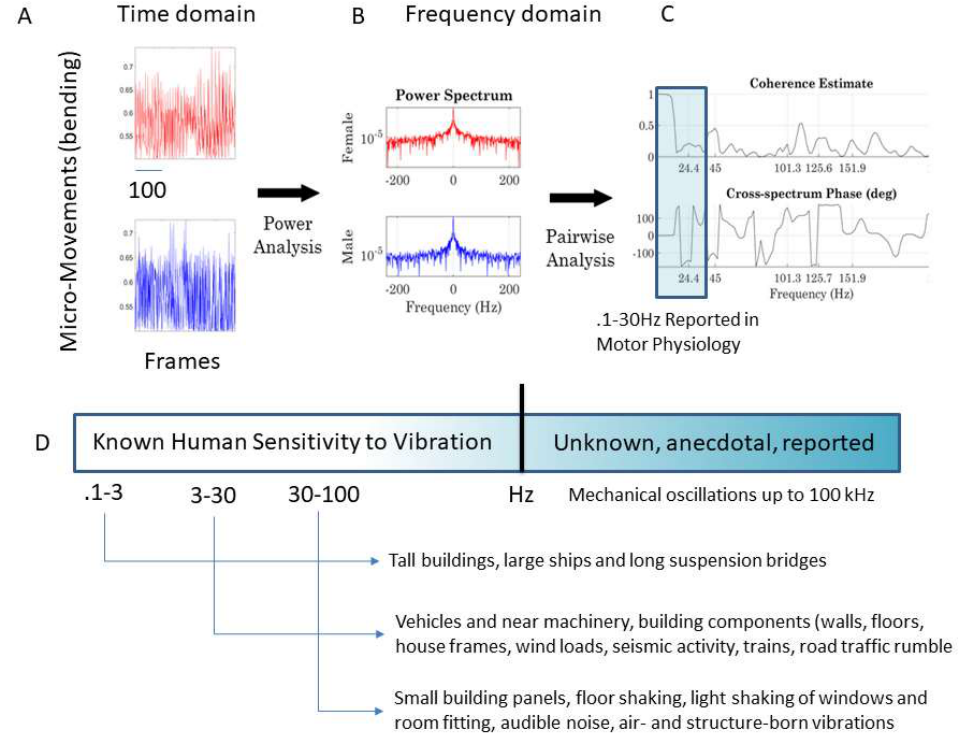
Figure 6. From the time to frequency domain. ( A ) The MM frames from different body nodes are FFT to perform power spectral analyses ( B ) and then pairwise cross-coherence analyses yield the frequency of the peaks (x-axis) and the phase shift (y-axis) in ( C ). ( D ) Frequency ranges studied in human motor control vs. other ranges studied in disciplines that ascertain levels of detectable vibration that may be in some cases harmful to the human nervous systems. Higher frequencies that are physiologically relevant to the vibro-tactile domain are of interest to build sensory-substitution